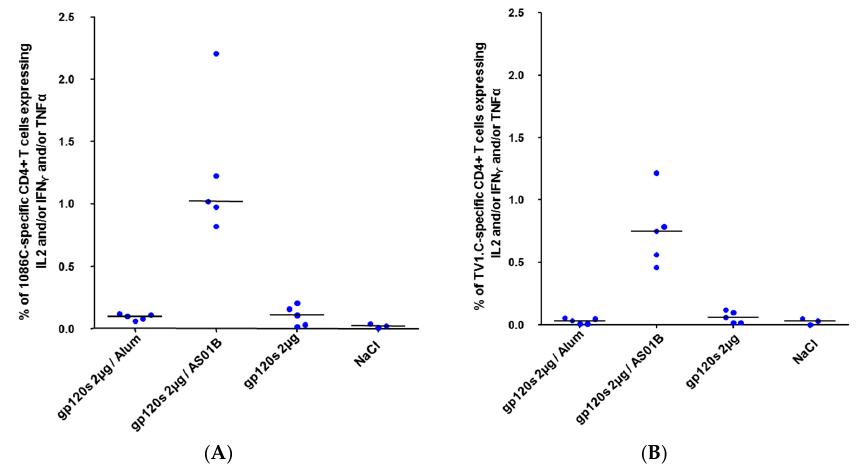
Figure 2. Antibody responses induced by bivalent Clade C gp120 (1086.C and TV1.C) alone or formulated with aluminum hydroxide or AS01 in CB6F1 mice: ( A ) anti-1086.C and ( B ) anti-TV1.C IgG binding antibody titers measured by ELISA 14 days post-second (blue) and third (red) immunization; ( C ) anti-gp70-V1V2 (Clade B/Case A2) binding antibodies measured by ELISA at 14 days post-third dose. Each dot corresponds to individual animals. Numbers of seropositive animals are shown for immunization schemes. Animals are considered seropositive if the titers are above 550 (the highest value measured from NaCl group). Statistical analysis: analysis of variance (ANOVA), with multiplicity adjustment using the Tukey method.